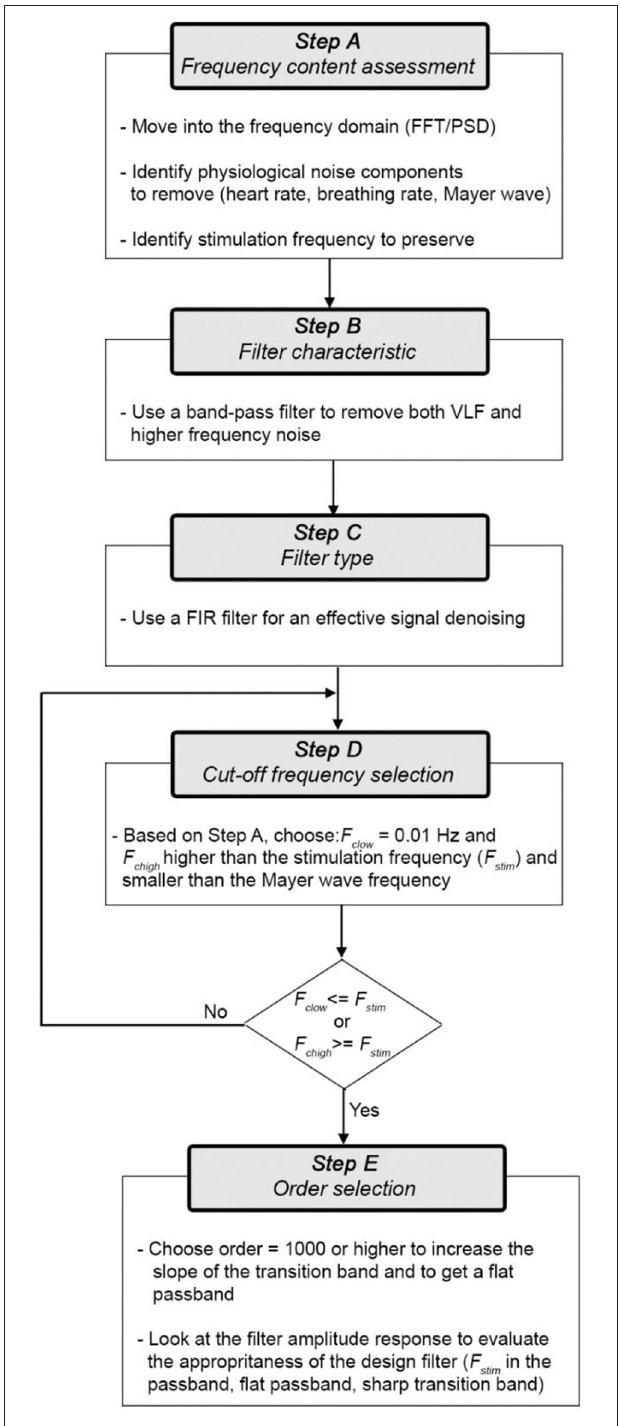
FIGURE 8 | Digital filter design flow-chart.